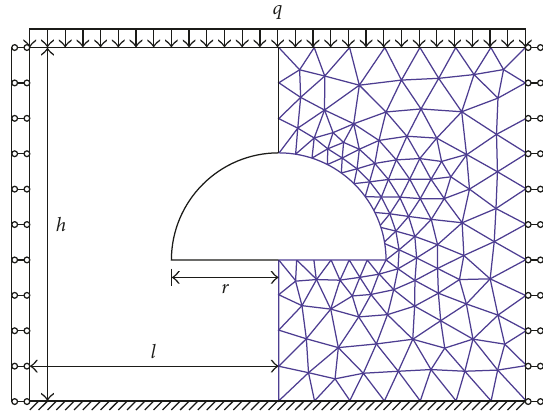
Figure 11: Geometry and mesh for the tunnel